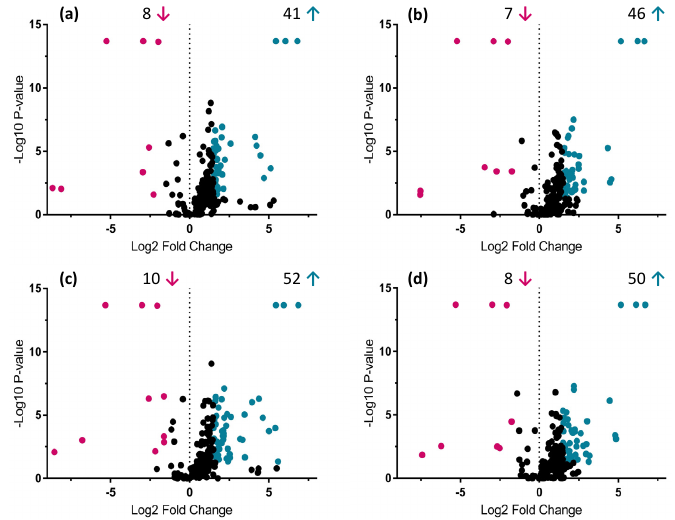
Figure 2. Volcano-plot analysis—Identification of up- and down-regulated compounds ( p -value < 0.05 and fold change > 1.5) between A. officinalis root samples associated with four AMF species ( R. irregularis , R. intraradices , R. clarus and R. aggregatus ) after 9 days of growth in the semi-hydroponic cultivation system. Comparison of metabolic profiles from root samples associated with ( a ) R. irregularis MUCL 41833 and R. clarus MUCL 46238; ( b ) R. irregularis MUCL 41833 and R. aggregatus MUCL 49408; ( c ) R. intraradices MUCL 49410 and R. clarus MUCL 46238; ( d ) R. intraradices MUCL 49410 and R. aggregatus MUCL 49408. Significant up-regulated compounds are represented in blue (right side of the plots) and down-regulated in magenta (left side of the plots). Blue and magenta arrows represent the amount of up- and down-regulated compounds, respectively, in the specific AMF-plants treatment.